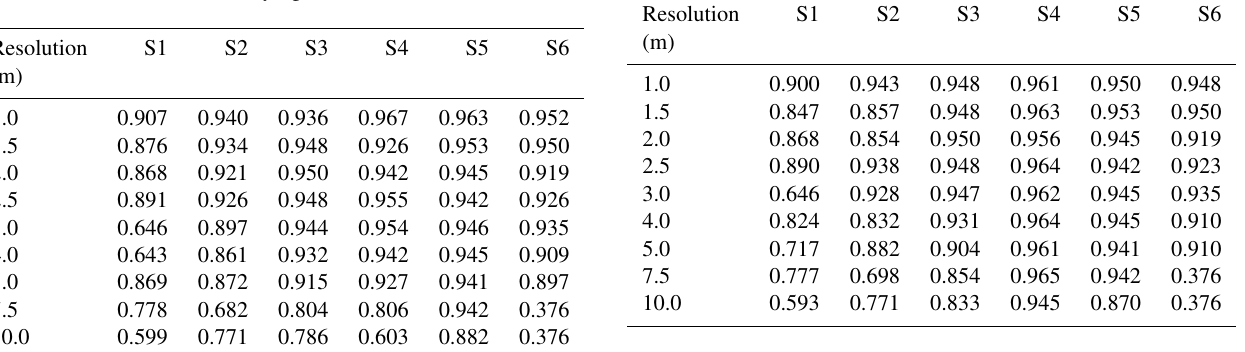
Table A1. Table of accuracy for sites S1 to S6 (columns) with no Wiener filter, for resolutions varying between 1 and 10m (rows).